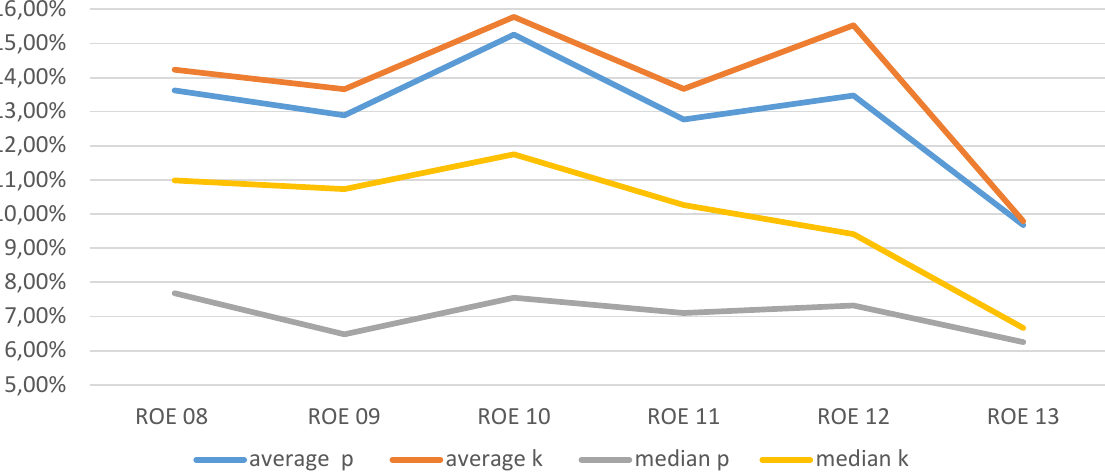
Figure 2. Statistical values of the ROE indicator over the